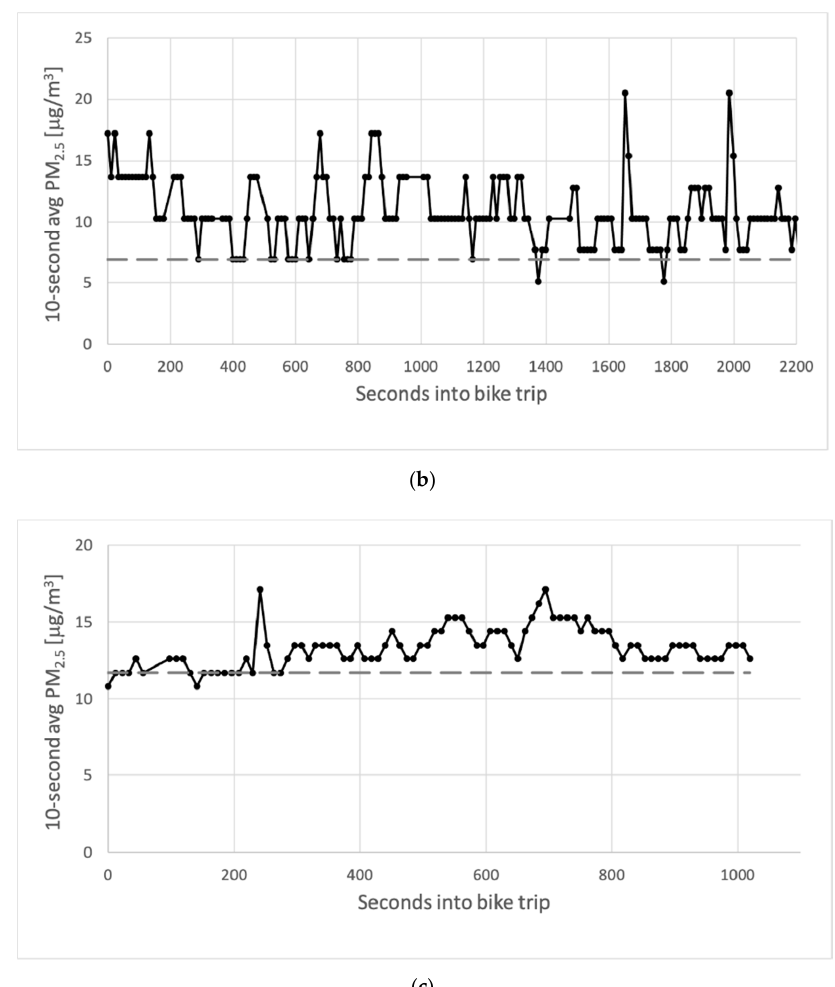
Figure 7. Several typical time series of measurements during bike trips. Concentrations in μ g/m 3 are plotted as a function of the seconds passed since the start of the trip. The dotted lines indicate the level of the assumed background concentration. ( a ) Measured concentrations during a bike trip on 21 January 2020; ( b ) measured concentrations during a bike trip on 23 May, 2020; ( c ) measured con- centrations during a bike trip on 10 August, 2020.